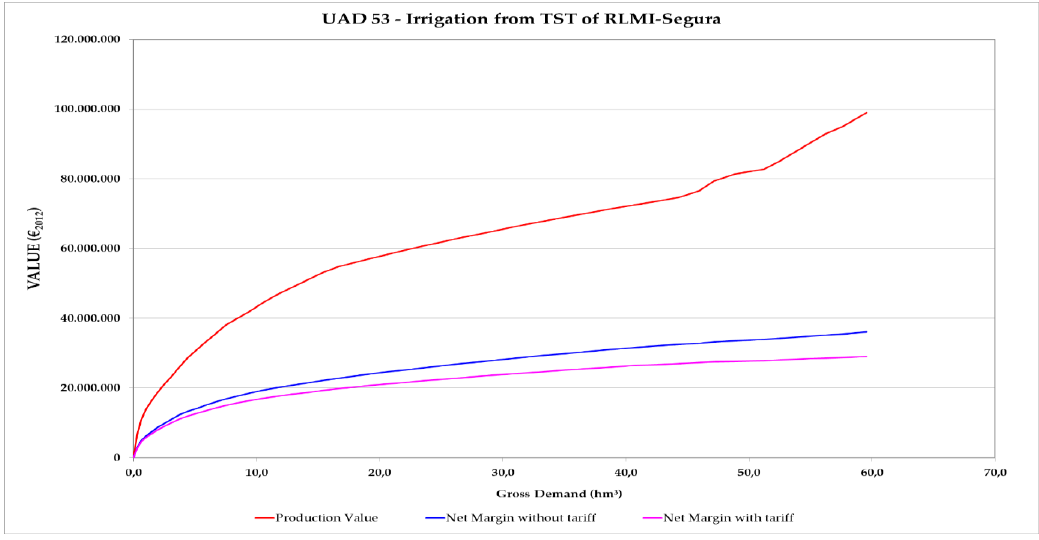
Figure 4. Net margin, with and without a tariff and the production value in UAD 53. Source: SBHP 2015/21.